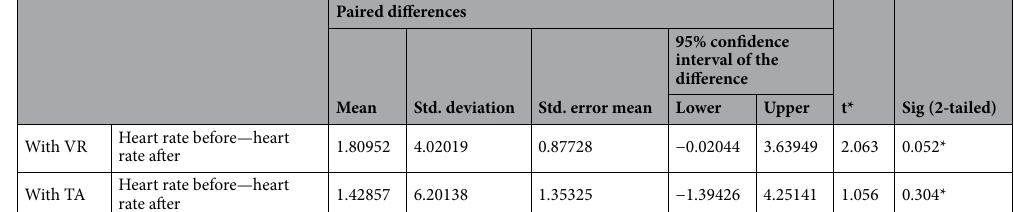
Paired differences